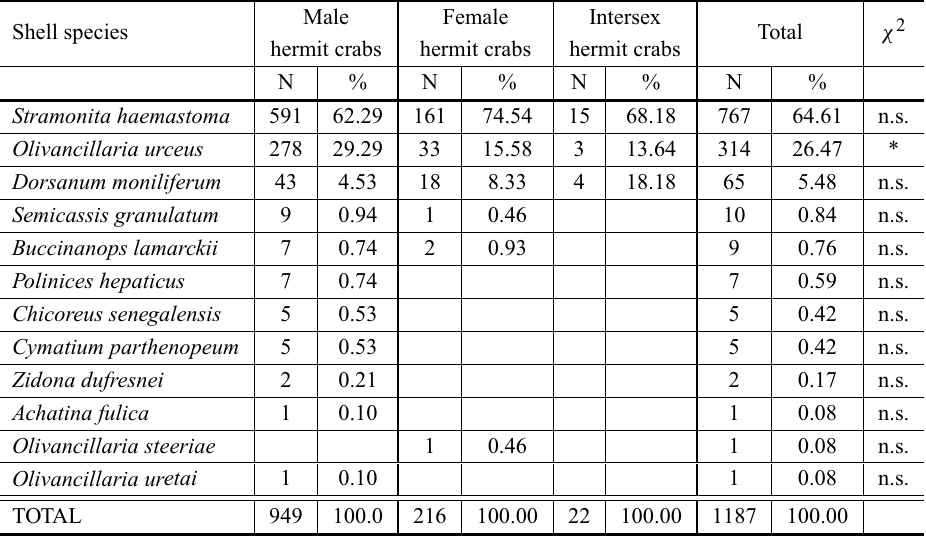
Clibanarius vittatus . Absolute and relative frequencies of occupation of 12 shell species by male, female and intersex hermit crabs.